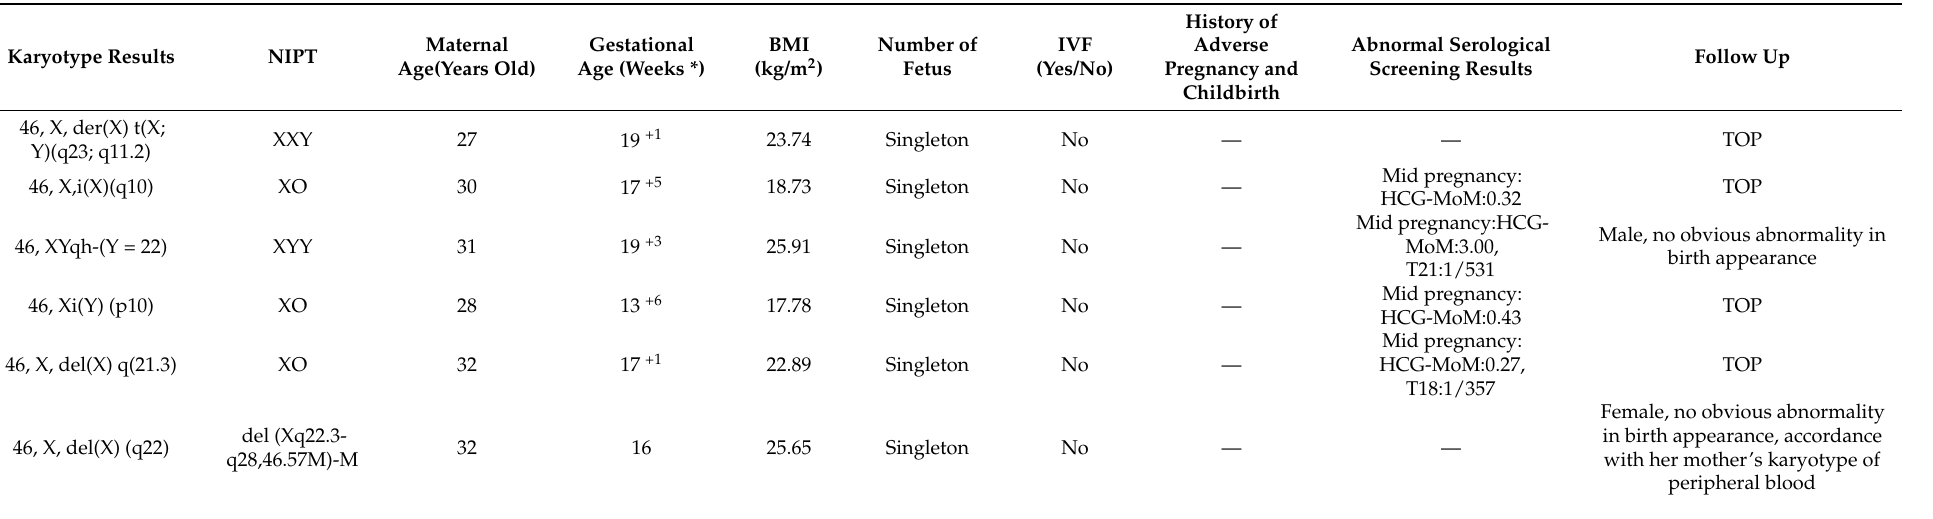
Table 3. Analysis of fetal karyotype with abnormal sex X and Y chromosome